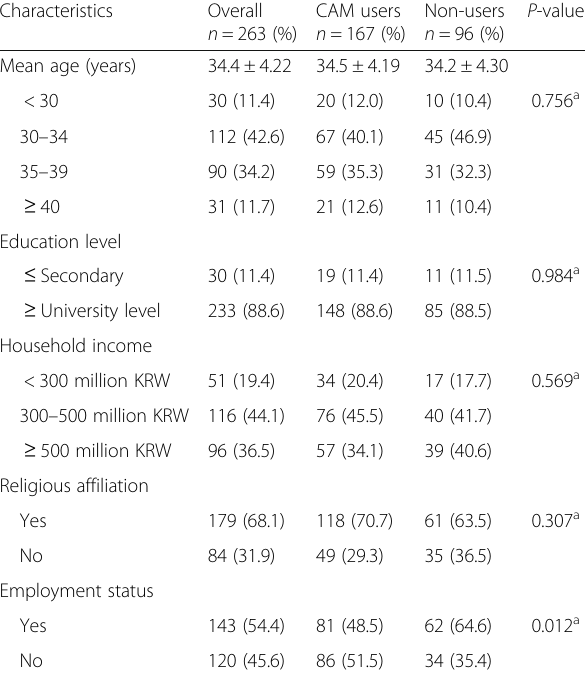
Table 1 Sociodemographic characteristics of participants Characteristics